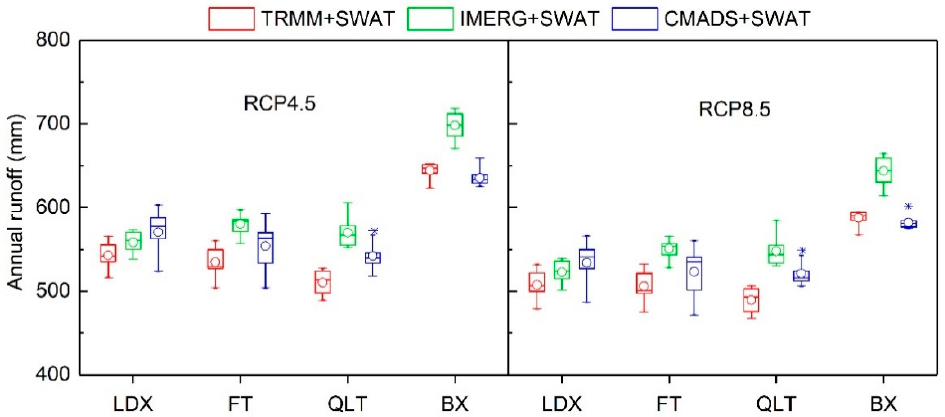
Figure 8. The uncertainty of the annual average runoff projection results of the three modes (CMADS + SWAT, IMERG + SWAT, and TRMM + SWAT) in 2021–2040 under RCP4.5 and RCP8.5. The hollow circle represents the mean value, the middle line in the box represent the median value, and each box ranges from the lower (25th) to upper quartile (75th).